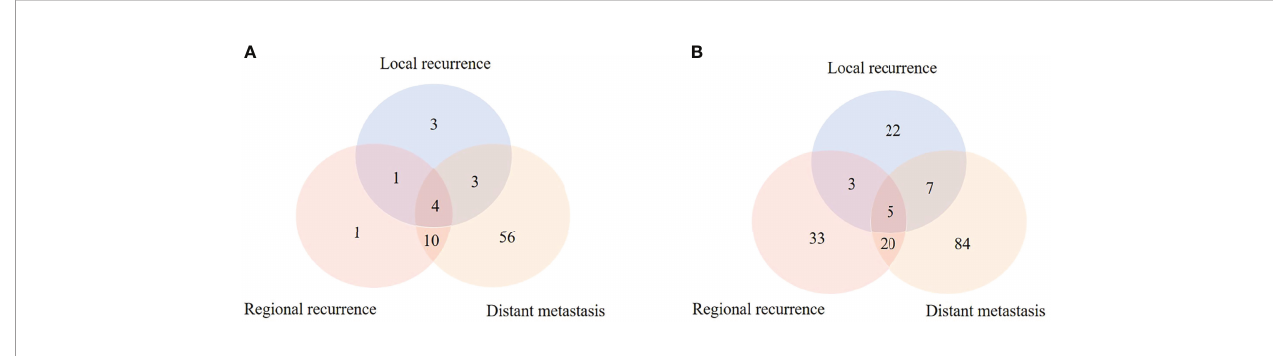
FIGURE 2 | The recurrence patterns in the CRT group (A) and CT group (B)